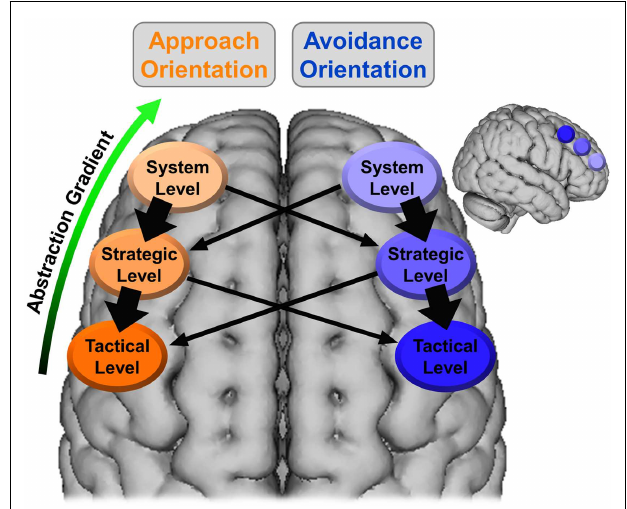
FIGURE 2 | Lateralized organization of superior, lateral prefrontal cortex with regard to the hierarchical model of motivation .The thickness of the arrows corresponds to the hypothesized strength of the relationship. The larger brain is an axial view of the superior surface of the brain viewed from above.The smaller brain is a sagittal view of the lateral surface of the right hemisphere.The location and coverage of the ovals/circles is meant to represent a relative placement rather than a delineation of specific